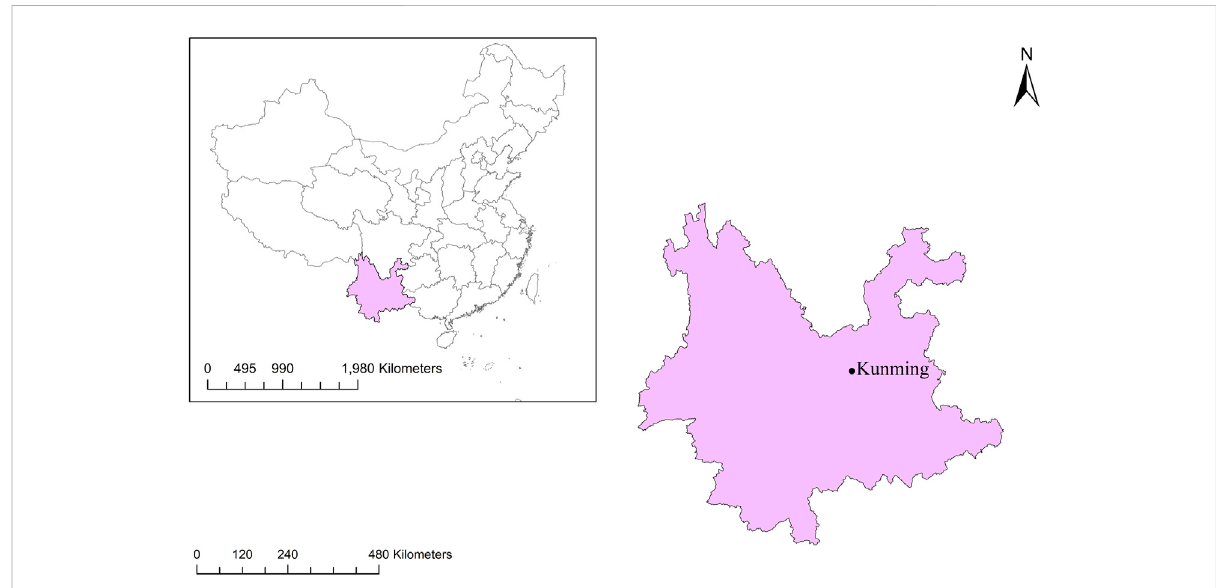
FIGURE 1 Location of the Kunming station.